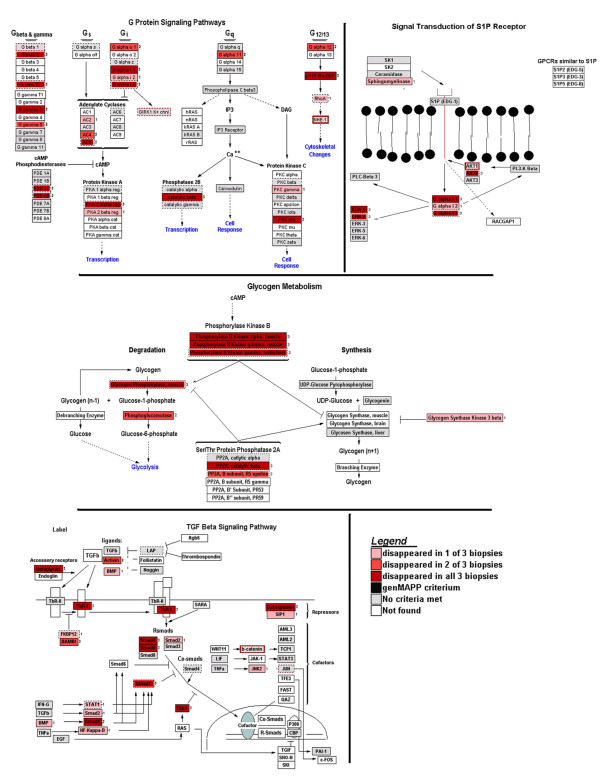
Visualization of low abundance reporters that disappeared after amplification in 1 to 3 LV biopsies (indicated with different shades of red), as compared to the expression profiles found in the parental LVs with the computer application GenMAPP. MAPPs with the highest z-scores in GenMAPP are shown; they represent four major signalling pathways.